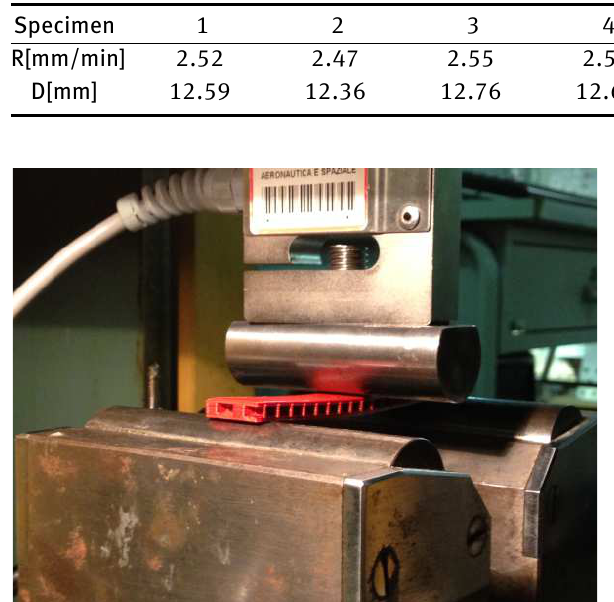
Table 3: Cross-head rate of motion R and deflection D at outer fibers strain equal to 0.05 mm/mm. Cross-head rate and deflection according to ASTM D790